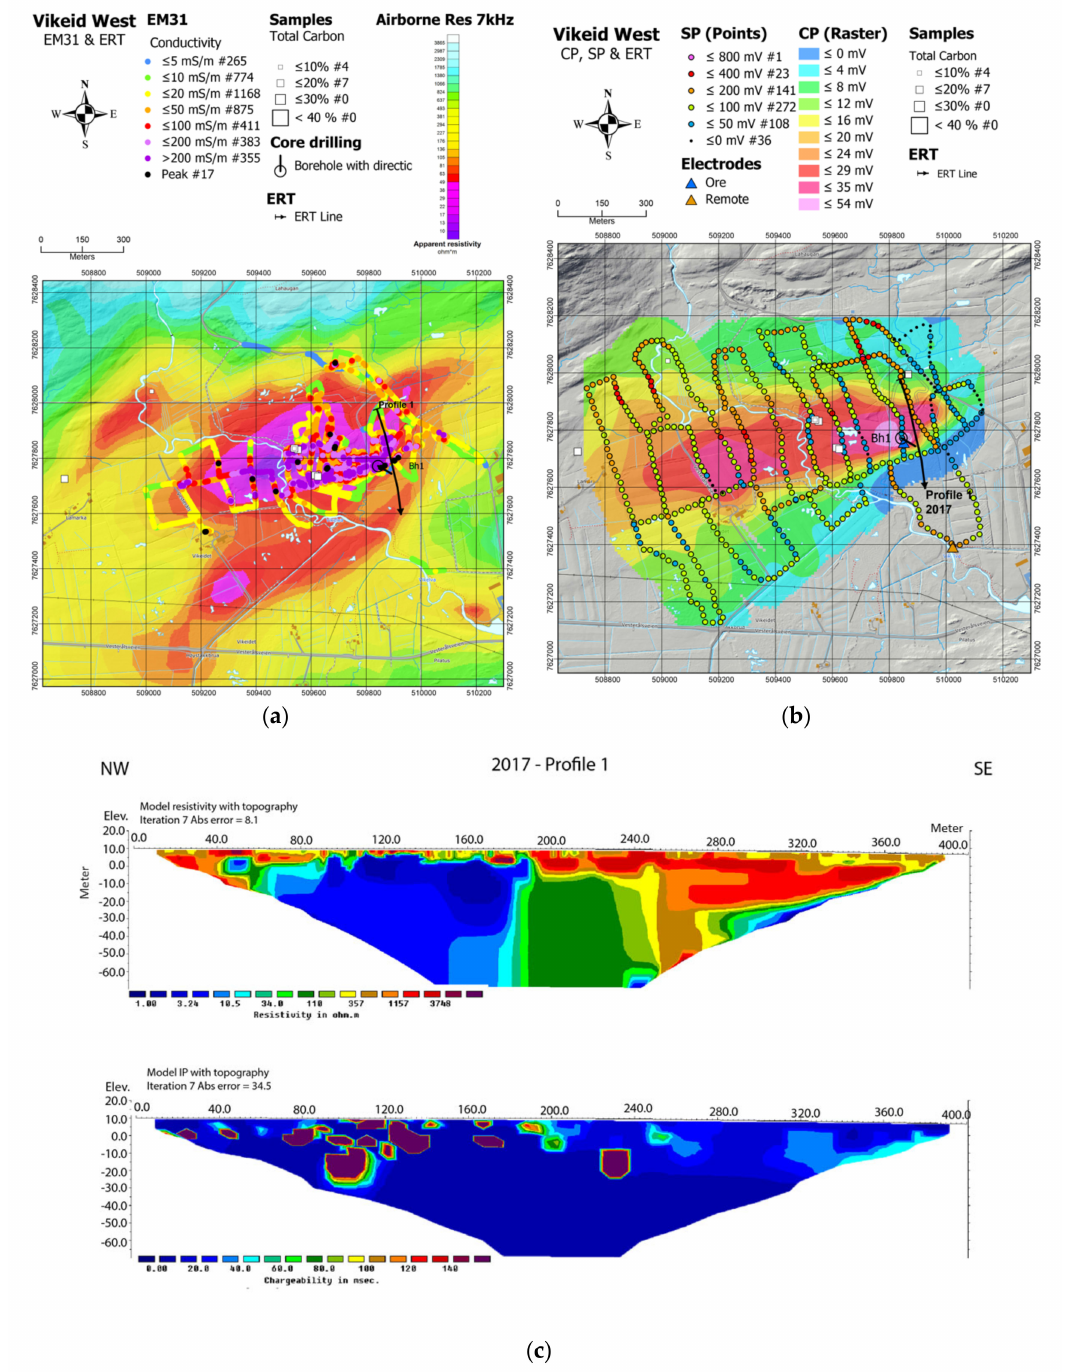
Figure 8. ( a ) Shows the airborne EM map with superimposed EM31 traverse, several highly conductive zones are apparent. ( b ) Grid map of CP measurements showing the dimensions of one individual graphite lens and superimposed measurements of SP, where several conductors are apparent. ( c ) ERT profile location shown on A and B. The upper part shows the variation in resistivity and soil cover is indicated. The lower part shows the variation in IP (induced polarization). Elevated IP shows the presence of electrically conducting material (graphite or sulphides). Based on data from